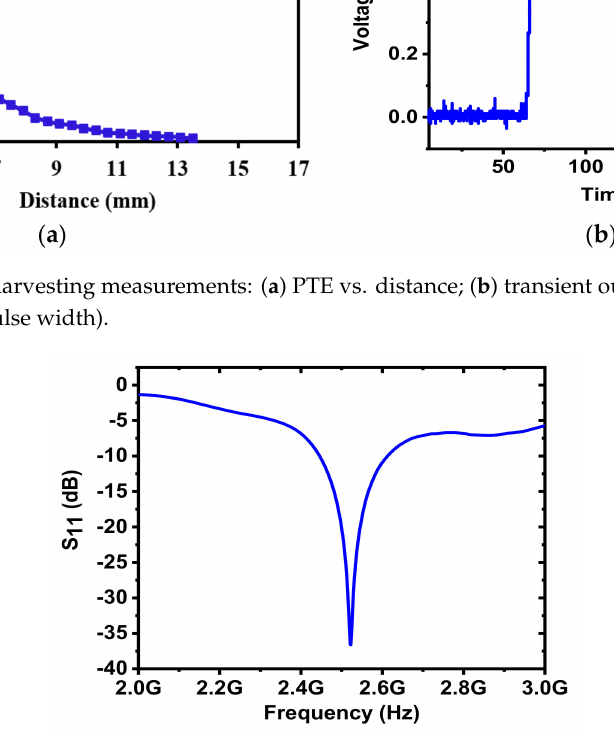
Figure 10. Measured S 11 of the Tx coil matched at 2.515